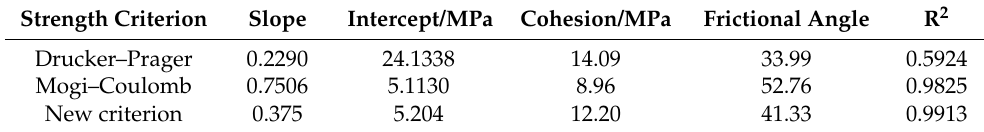
Table 3. Comparative analysis on strength criterion parameters.